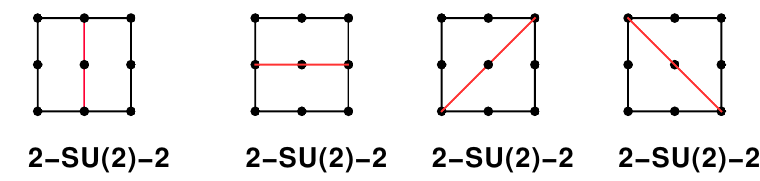
Figure 13 . Non-abelian gauge theory descriptions for a rank one toric diagram.